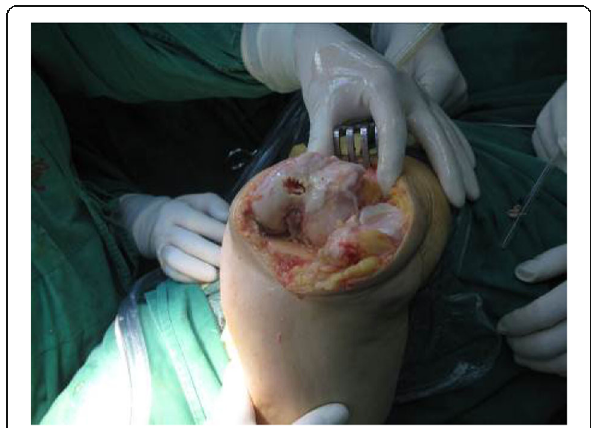
Fig. 1 The entry point of the intramedullary rod was medialized by 1 – 2 mm